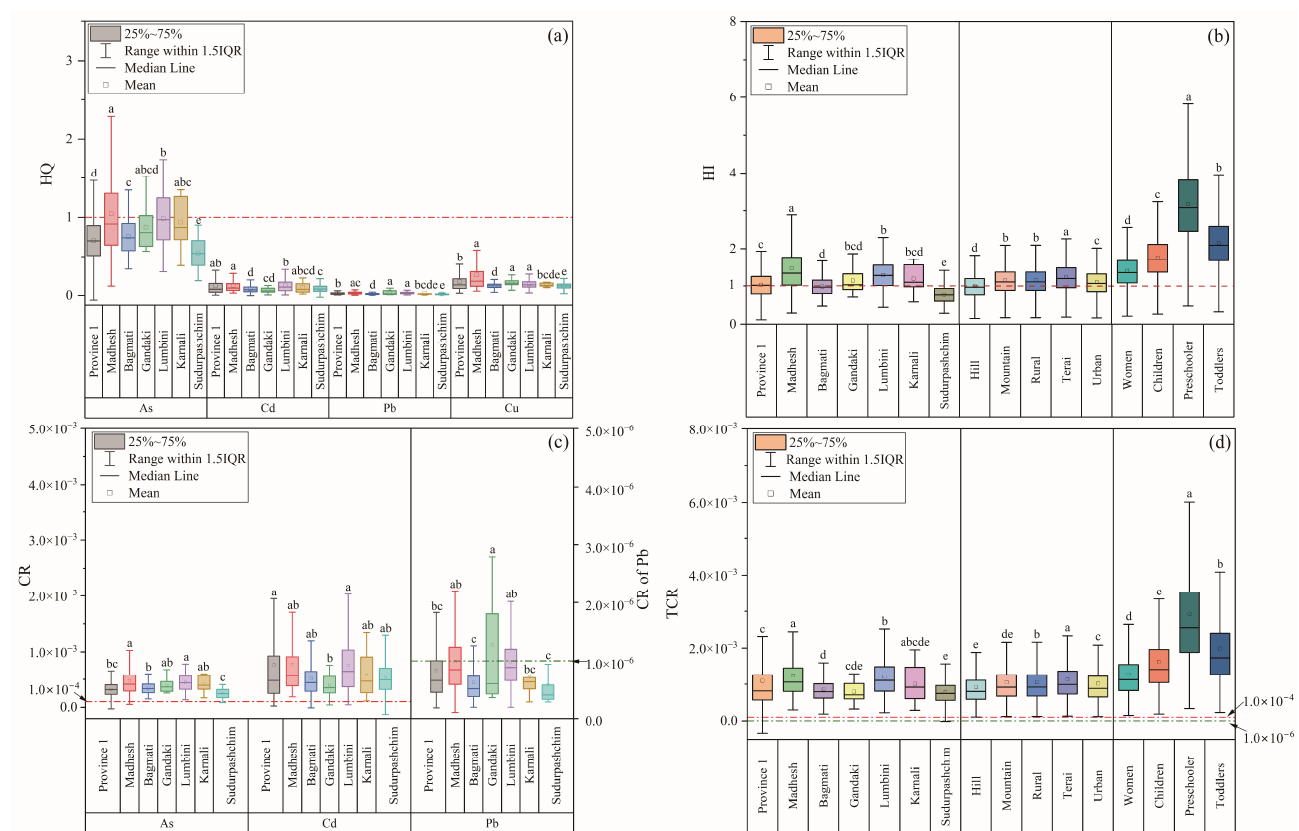
Figure 4. (a) The distribution of HQ, (b) the distribution of HI, (c) the distribution of CR, and (d) the distribution of NCR in Nepal. Note: different lower case letters suggest the significant difference at level p < 0.05.